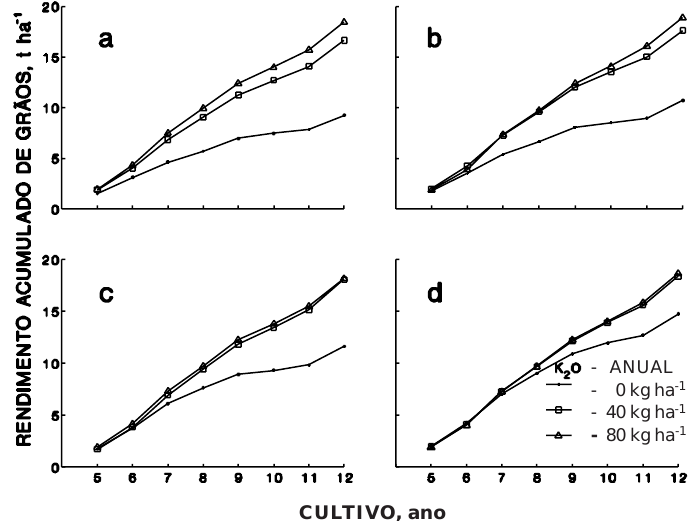
Figura 2. Rendimento acumulado de grãos de soja, em resposta às doses de adubo potássico (0, 40 e 80 kg ha